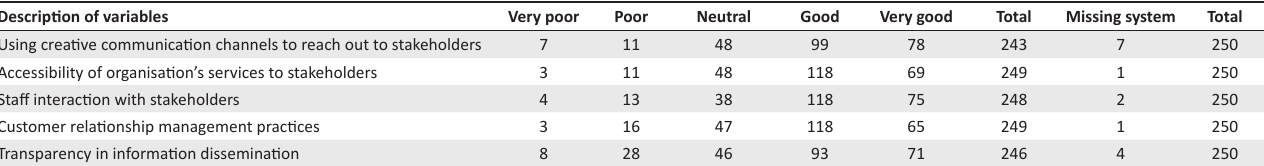
TABLE 4: Using only frequencies. Description of